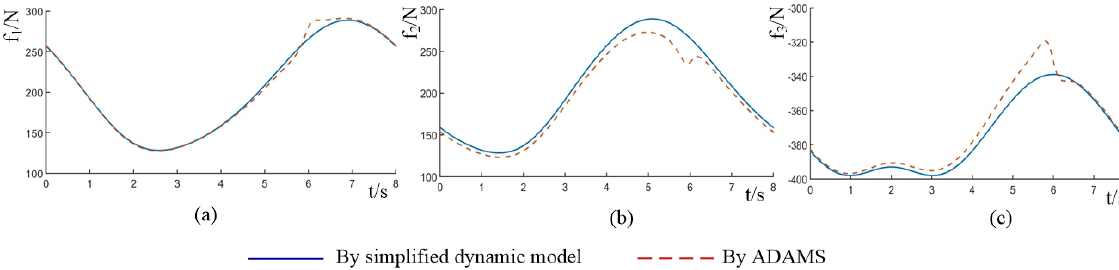
Figure 12. Actuating force of each limb: (a) Actuator 1, (b) Actuator 2, (c) Actuator 3.